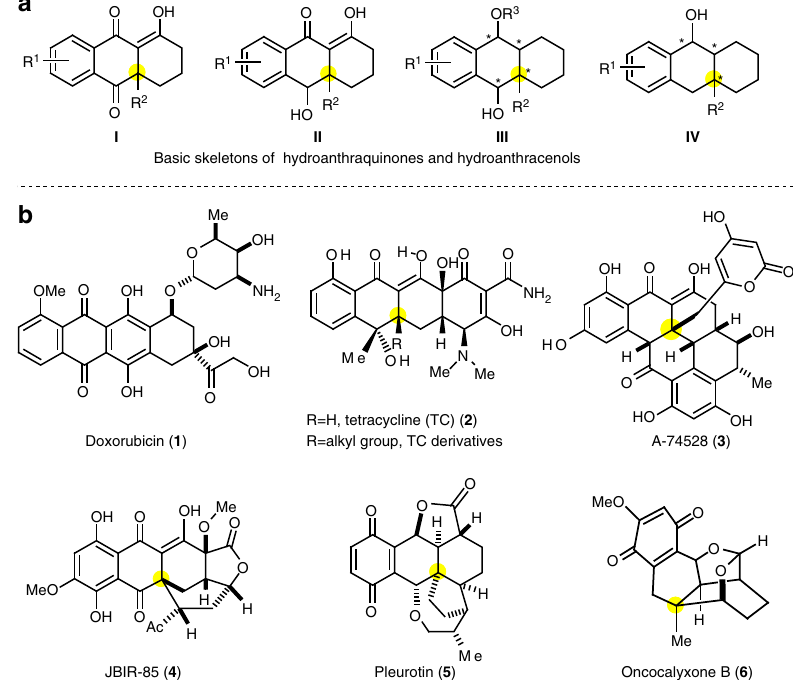
Fig. 1 Natural products containing anthracenols or anthraquinones. a The basic skeletons ( I – IV ) of hydroanthraquinones and hydroanthracenols contain linearly fused six-membered rings with various oxidation states and consecutive stereogenic centers. b Doxorubicin ( 1 ) and tetracycline ( 2 ) are anticancer and antibiotic drugs containing anthraquinone and anthracenol, respectively. A-74528 ( 3 ) and JBIR-85 ( 4 ), pleurotin ( 5 ) and oncocalyxone B ( 6 ) are structurally related polyketides bearing all-carbon quaternary centers within the core anthracenols or anthraquinones NATURE COMMUNICATIONS | 8: 622 | DOI: 10.1038/s41467-017-00440-8 |